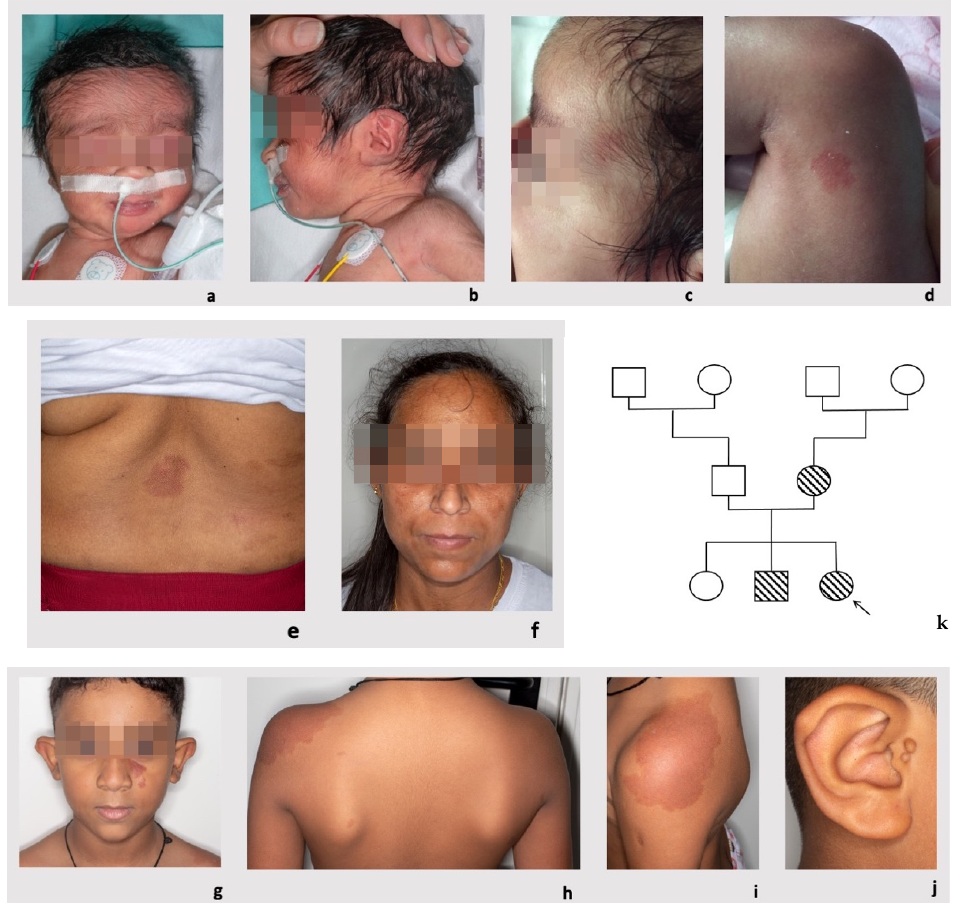
Figure 1. Patient 1. Proband: clinical features at 80 days: small capillary malformations of round or oval shape were evident on the face ( a – c ) and lower limbs ( d ). Mother: Capillary malformations on the face and thoracolumbar region ( e , f ). Brother: Capillary malformations on the face and left shoulder ( g – i ); pre-auricular tags on the tragus involving the right ear ( j ). Pedigree of Patient 1’s family ( k ).